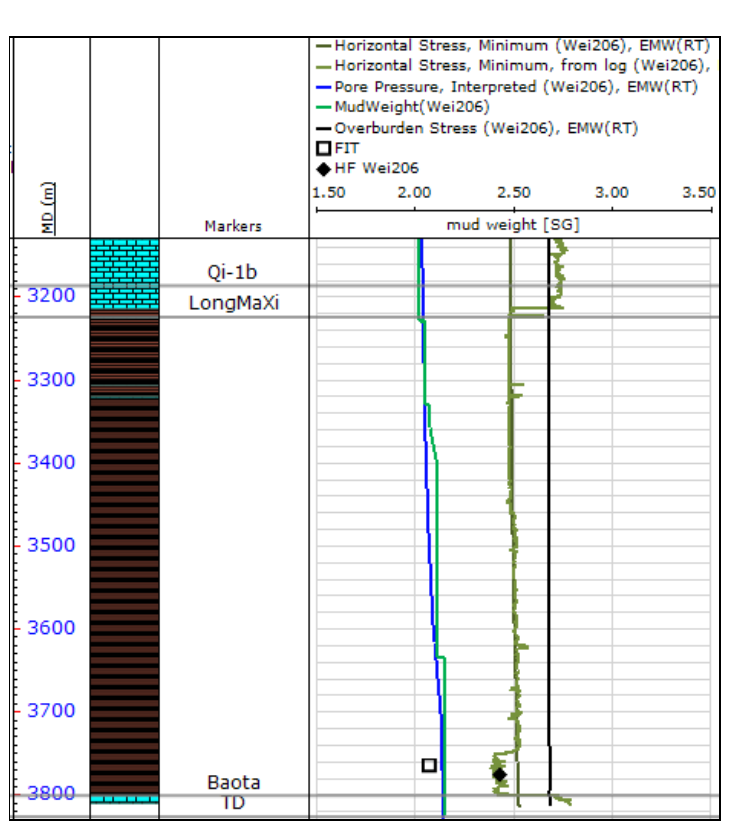
Figure 16. S hmin profile of W206.